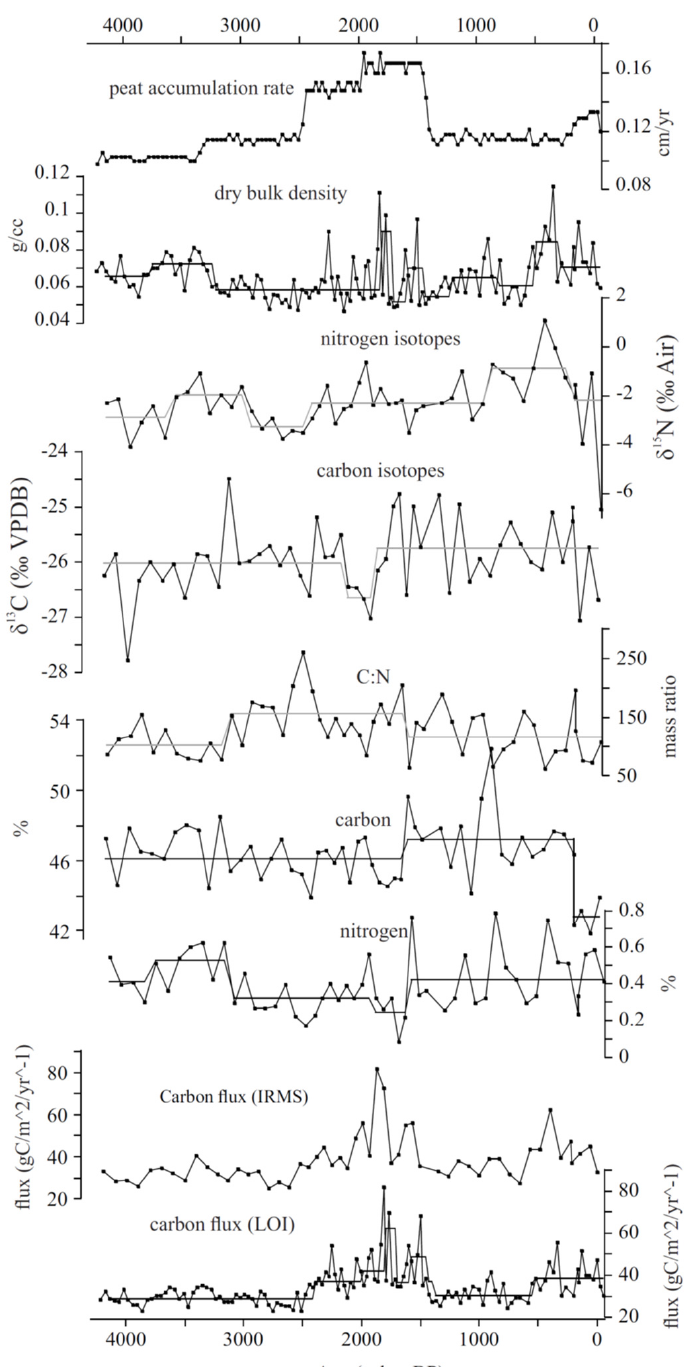
Figure 8. Peat core data. Solid black lines represent the mean values computed by regime-shift analysis. Time-series analyses were performed on all environmental datasets. Significant regime shifts in all time-series data were identified using Sequential Regime Shift Detection soft- constant of 1 (Figures 8 and 9). A Principal Component Analysis (PCA) of the sedimen- tological, stable isotope ( δ 13 C and δ 15 N) and bulk geochemical data was done using the R FactoMineR package [43], after scaling the data by variance (Figure 10). The PCA also includes late Holocene temperature data from Fennoscandia [44] and water table data from Männikjärve Bog in Estonia